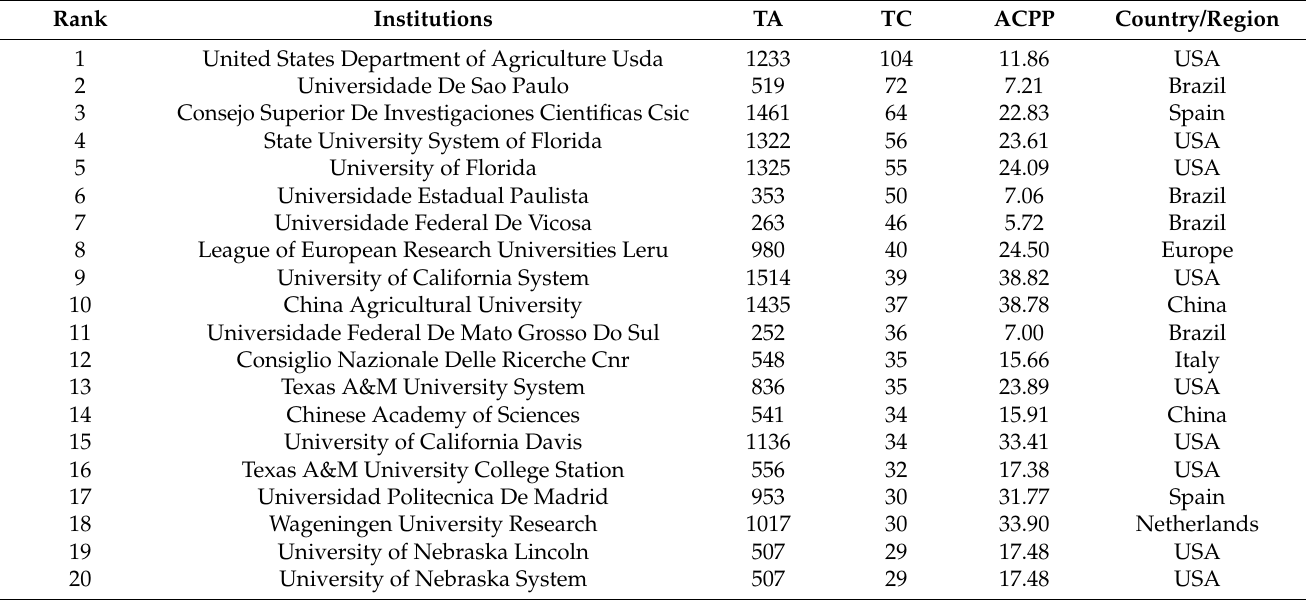
Table 6. Mechanism impact